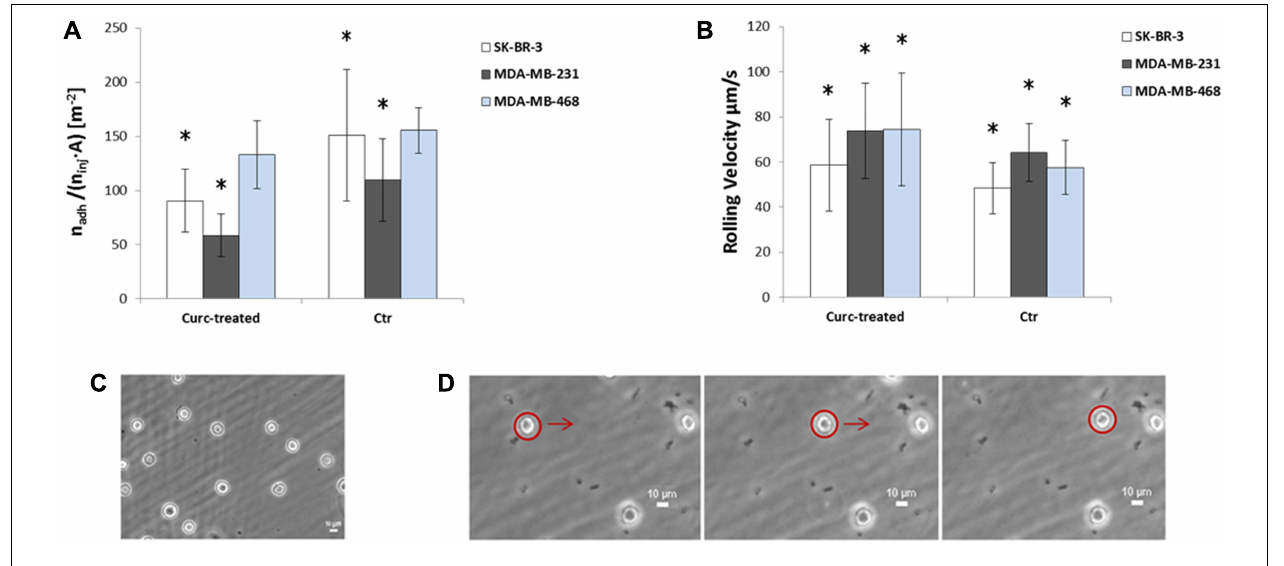
FIGURE 4 | (A) Adhesion and (B) rolling behavior of SK-BR-3 (white), MDA-MB-231(gray), MDA-MB-468 (blue) cells treated with curcumin (Curc-treated) at 10 μ M for 24 h, and not treated cells (Ctr).The number of firmly adhering cells ( n adh ) is normalized by the total number of injected cells ( n inj = 10 6 ) and the area of the region of interest ( A = 0.33 × 10 − 6 m 2 ). Data